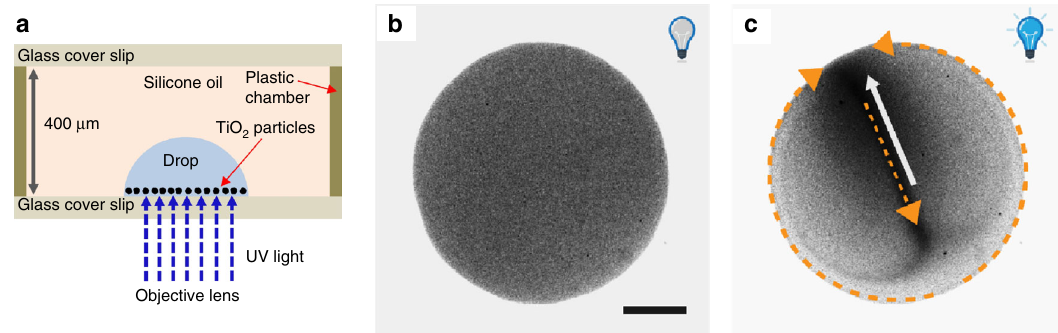
Fig. 2 Emergence of self-organized vortical fl ow patterns in a drop. a Schematic representation (not to scale) of the experimental set-up. b , c Motion of TiO 2 particles, forming a sedimented monolayer at the bottom of a drop of hydrogen peroxide solution, for a high areal number density ( ≈ 40% of the area is covered by the particles). Upon illumination with UV light, the equilibrium uniform distribution of the particles — at the bottom surface and in the absence of UV illumination ( b ) — evolves after a transient time to a steady fl ow pattern and collective motion of the CAPs as indicated schematically by the orange arrows ( c ). The scale bar corresponds to 100 μ m. For the de fi nition of the polarity d of the drop (white arrow in c ), see the